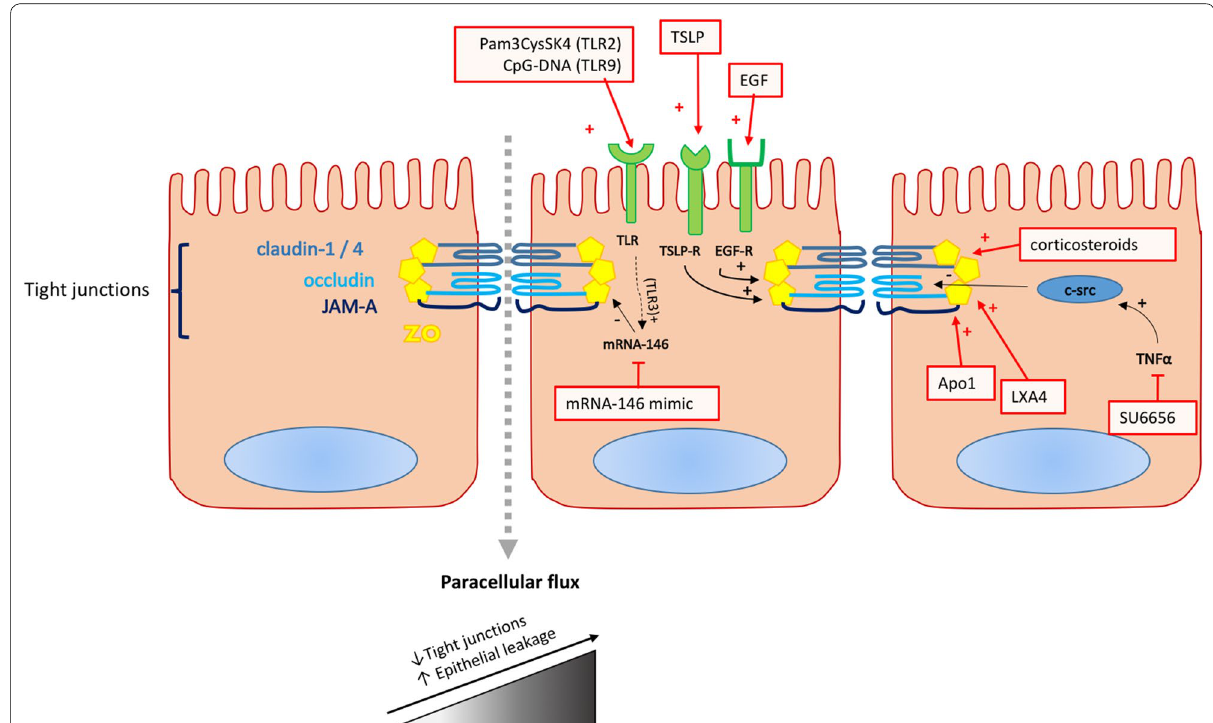
Fig. 5 Barrier dysfunction and potential biomarkers. EGF epidermal growth factor; EGF - R epidermal growth factor receptor; JAM - A junctional adhe- sion molecule A; TLR toll-like receptor; ZO zona